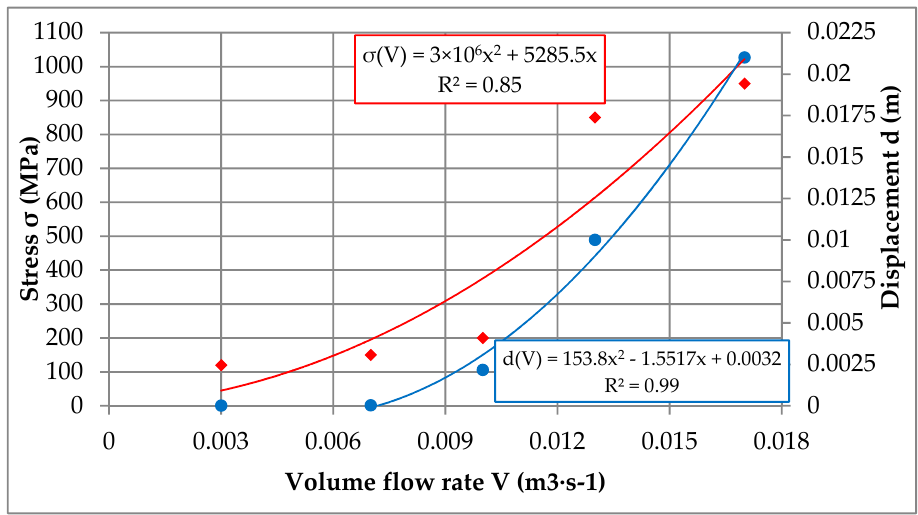
Figure 21. The variation curves of von Mises stress ( σ ) (red curve) and displacement ( d ) (blue curve) depending on the volume flow rate.